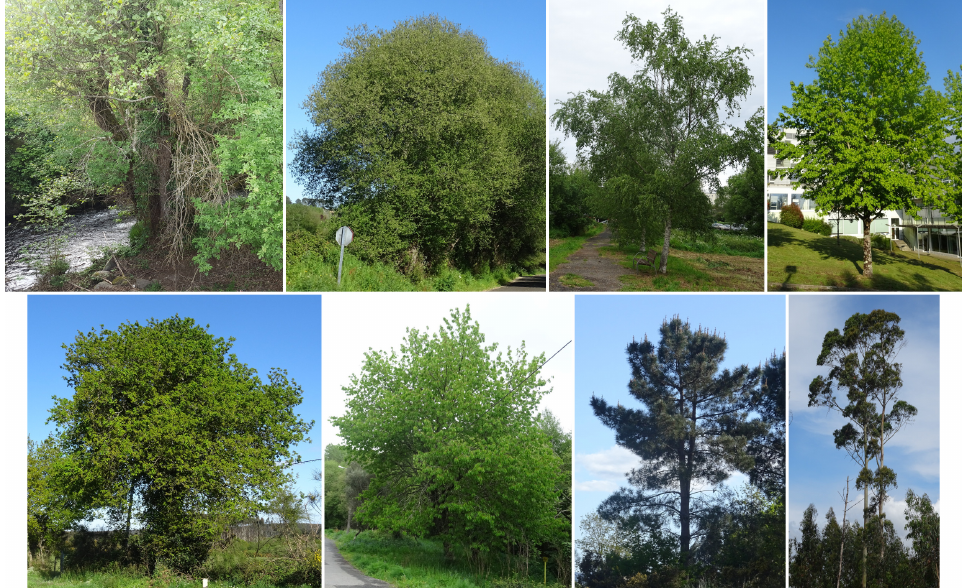
Figure 7. Tree species present in the riparian zones of Galicia. Top: alder ( Alnus glutinosa ), large gray willow ( Salix atrocinerea ), silver birch ( Betula pendula ), and white maple ( Acer pseudoplatanus ). Bottom: common oak ( Quercus robur ), elm ( Ulmus minor ), and the invasive species maritime pine ( Pinus pinaster ) and Eucalyptus globulus